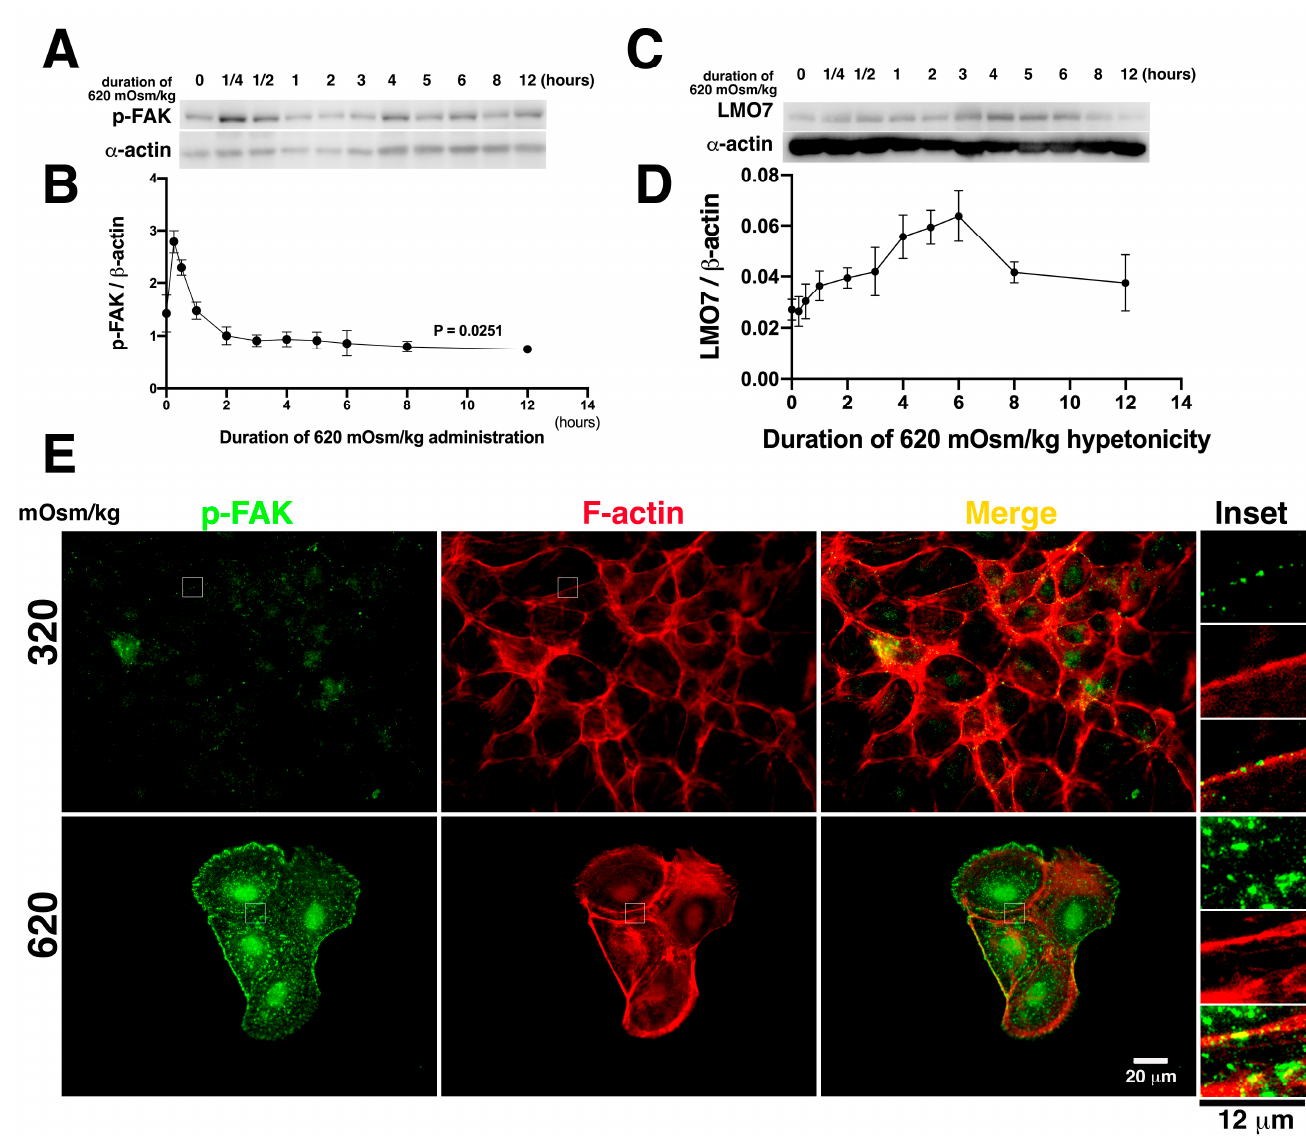
Figure 4. Osmotic induction leads to FAK phosphorylation and its localization at focal adhesion. ( A ). Focal adhesion kinase (FAK) phosphorylated on tyrosine 576/577 (p ‐ FAK) is validated in NRK ‐ 52E cells exposed to various 620 mOsm/kg hypertonic medium durations. p ‐ FAK reaches the highest level at 15 min after 620 mOsm/kg exposure. Subsequently, p ‐ FAK levels abruptly decrease. One hour after hypertonic stimulation, p ‐ FAK levels in NRK ‐ 52E cells are similar to those in cells without osmotic stimulation. After hypertonic stimulation for 4 h, p ‐ FAK levels remain almost constant in NRK ‐ 52E cells. ( B ). The p ‐ FAK levels in NRK ‐ 52E cells treated with 620 mOsm/kg hypertonic dura ‐ tion are plotted in a time ‐ dependent curve. The p ‐ FAK levels are highest in cells exposed to 620 mOsm/kg hypertonic medium for 15 min. ( C ). LMO7 expression in NRK ‐ 52E cells exposed to 620 mOsm/kg were evaluated by Western blot analysis. ( D ). The LMO7 protein band densities were digitalized and normalized to corresponding β‐ actin bands. Ratio of LMO7 to β‐ actin were plotted in a time ‐ dependent curve. ( E ). p ‐ FAK translocates to focal adhesions in NRK ‐ 52E cells cultured in 620 mOsm/kg hypertonic medium.